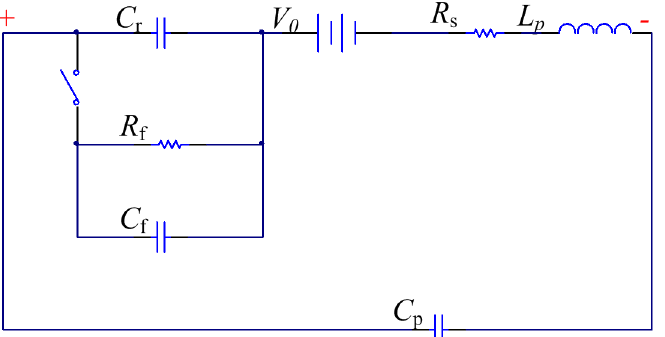
Fig 3. Equivalent circuit of the